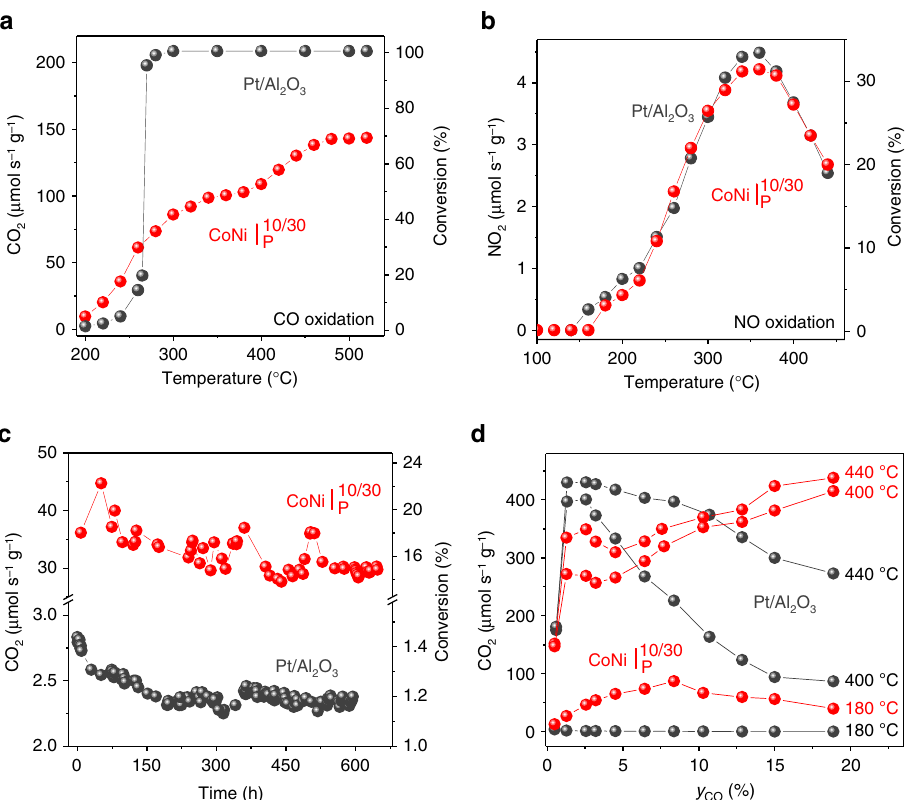
, red and Pt/Al 2 O 3 , black. Catalytic rates are P